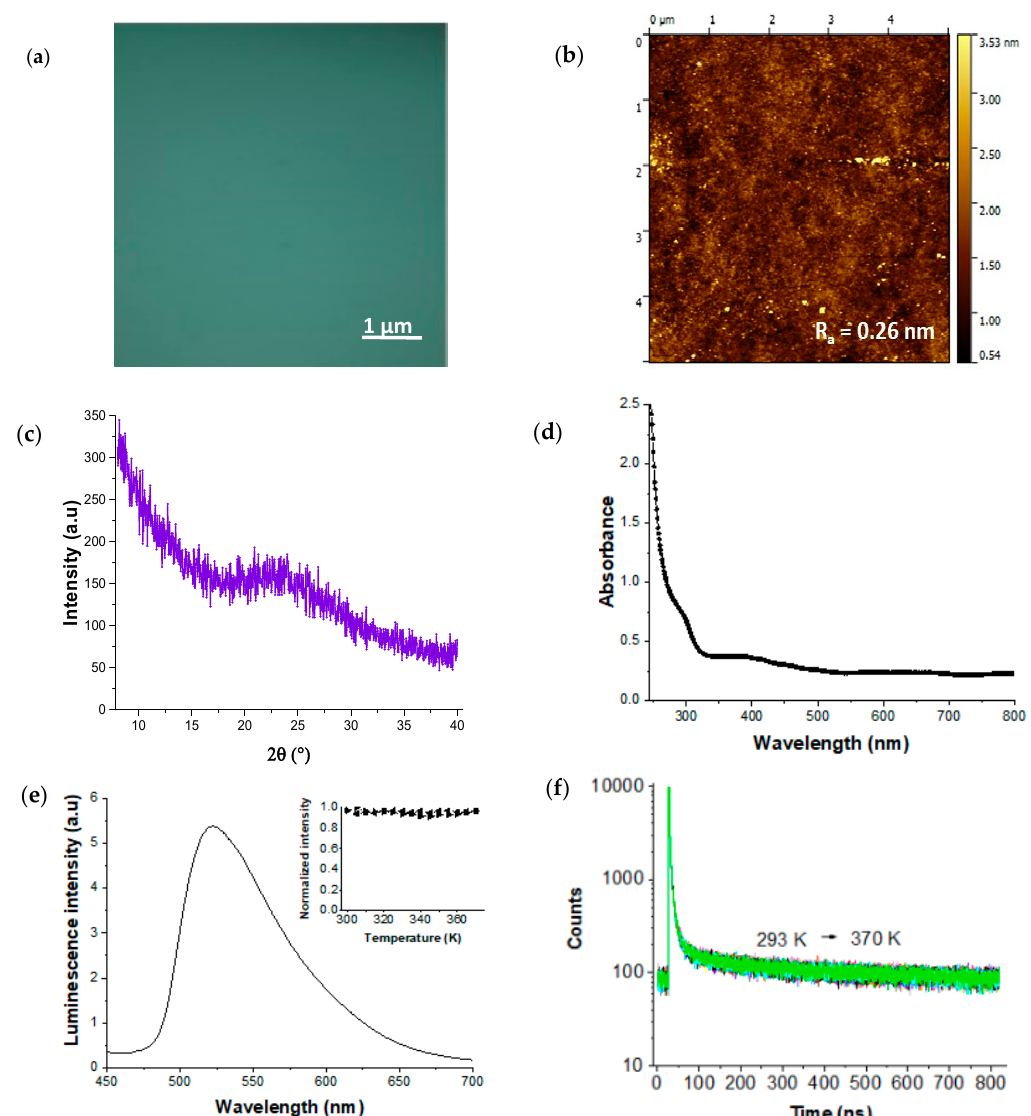
Figure 1. Characterization of films of Ir(PPy) 3 . Typical optical microscopy ( a ) and AFM topography ( b ) images, ( c ) GIXRD pattern, ( d ) UV-vis absorption spectrum, ( e ) luminescence emission spectrum (excitation: 300 nm, high pass filter λ emission > 400 nm) and its temperature dependence in insert and ( f ) variable temperature luminescent decay curves (excitation: 303 nm, emission 520 nm) recorded over the first 800 ns of the decay.